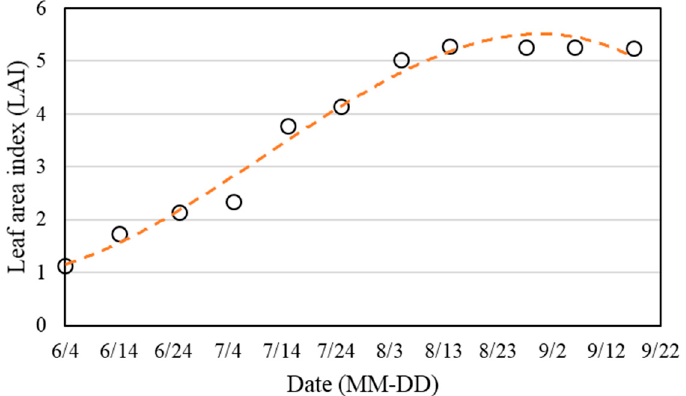
Figure 8. Change of tomato LAI measured through the destruction investigation (circle: measured LAI and dotted line: changing trend). LAI and dotted line: changing trend).